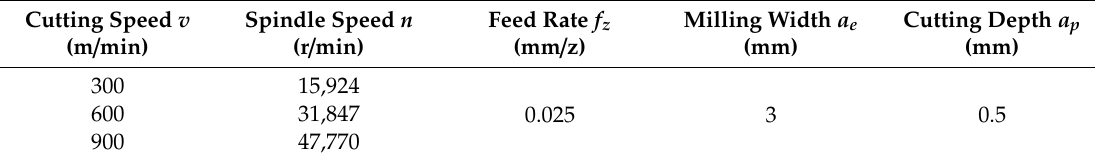
Figure 9. ( a ) Cycloid finite element model; ( b ) experimental setup of high-speed milling. Table 2. The parameters of milling experiments.